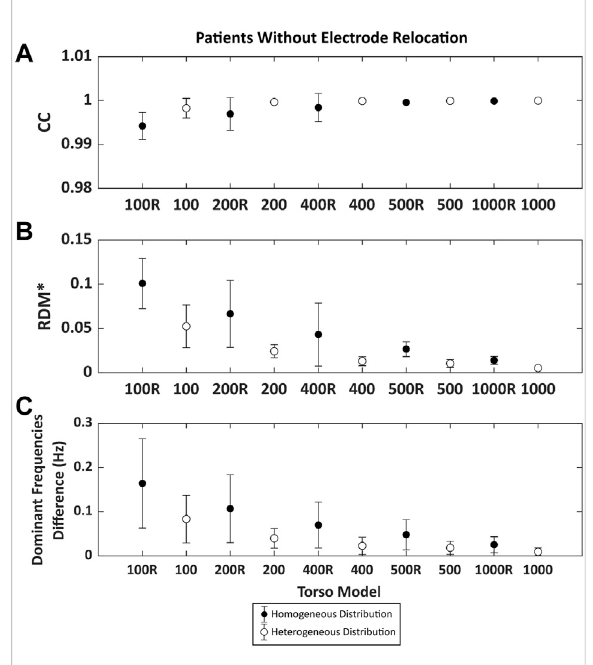
FIGURE 5 Time metrics obtained comparing the inverse computed electrograms 25 atrial fi brillation patients of the reference and the signals obtained with different torso models without electrode relocation. Points in black represent the torsos in which the distribution of the nodes is homogeneous and white points represent the torso with nodes heterogeneously placed. (A) . Pearson ’ s correlation coef fi cient (CC) and (B) . Relative difference measurement (RDM*). (C) . Mean absolute difference between the reference dominant frequencies (DF) between torso models and from 100 to 1,000 down to 0.38 ± 0.09 for the 2000 node mesh. Regular meshes do show better correlation coef fi cients and RDM* values than irregular meshes with a similar number of nodes, especially for the meshes with a lower number of nodes. For the fi ner meshes and, therefore, smaller areas of the geometrical faces, slightly better results are observed for the irregular meshes.